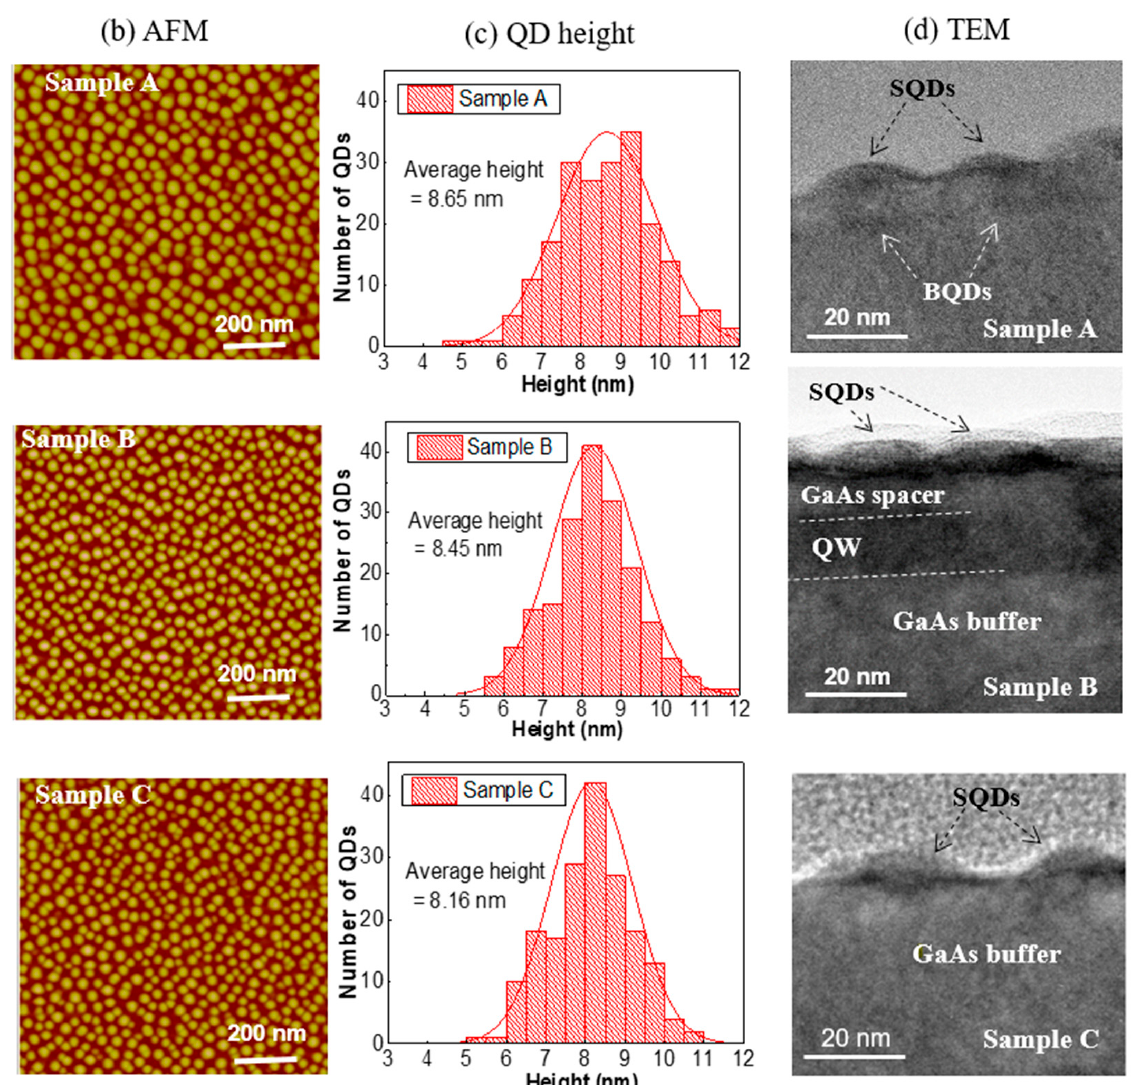
Figure 1. Sample structures and characterizations: ( a ) diagram of sample structures; ( b ) 1 μ m × 1 μ m AFM images of SQDs; ( c ) the QD height distribution extracted from the corresponding AFM image; ( d ) the cross-sectional TEM images showing the SQDs with adjacent BQDs and QW structures.